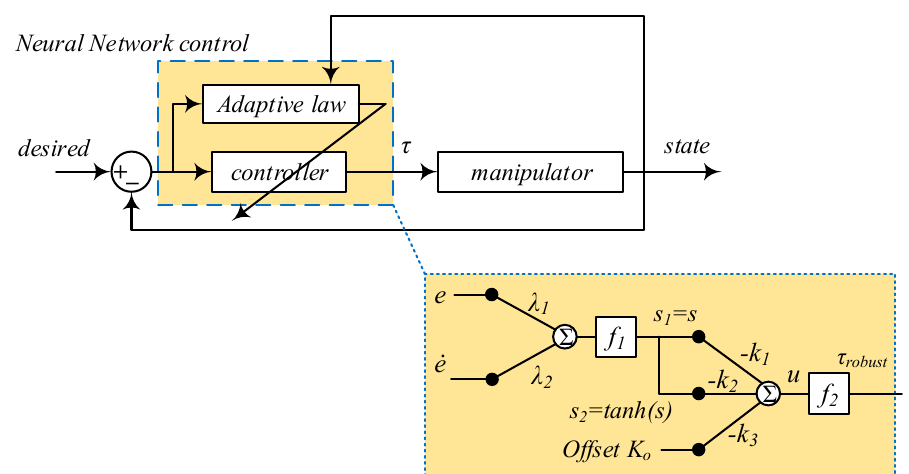
Figure 4. An architecture of the proposed neural network based sliding mode control.